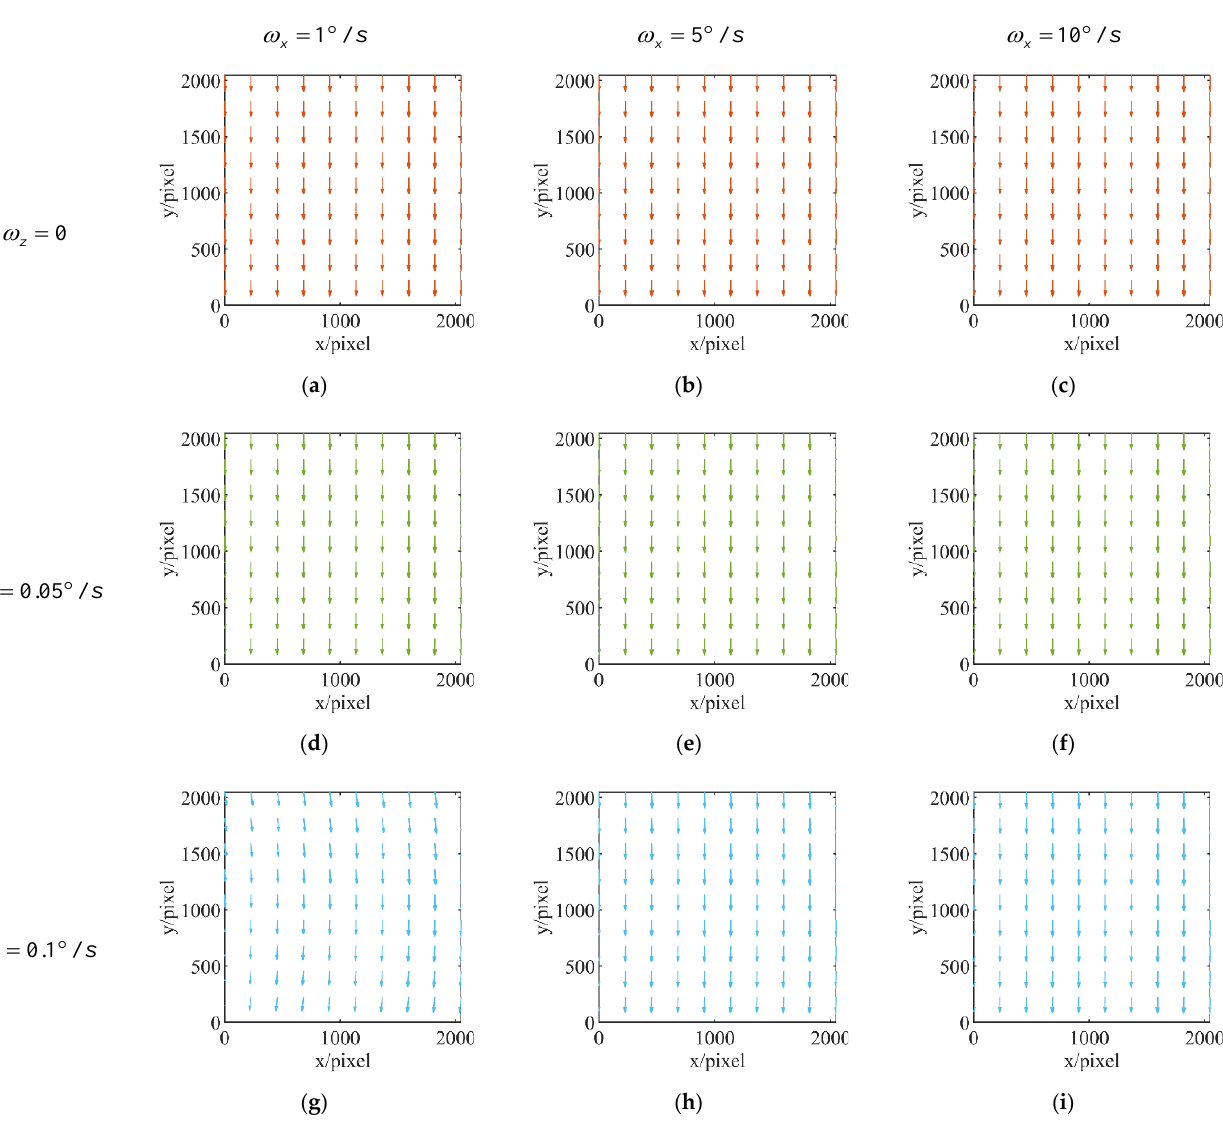
Figure 6. Velocity vector distribution diagram for different angular velocities. ( a – c ) The distribution of the velocity vector when ω z is equal to 0. ( d – f ) The distribution of the velocity vector when ω z is equal to 0.05 ◦ /s. ( g – i ) The distribution of the velocity vector when ω z is equal to 0.1 ◦ /s. As shown in Figure 6, the direction of star centroid velocity remains straight when ω z is equal to zero, and there is little effect on the velocity direction when ω z is not equal to zero. To analyze the specific effect of ω z on star centroid velocity, we analyze the magnitude and direction of the velocity when ω z is equal to 1 ◦ /s. As shown in Figure 7a, the direction of the velocity caused by ω z is symmetrical about the center of the field of view, and the velocity vector at the edge of the field of view has a larger magnitude than the velocity vector at the center of the field of view. The maximum velocity does not exceed 1.5 pixel/s. The star centroid is determined by the velocity and exposure time. The angular velocity error caused by the satellite control system is less than 0.01 ◦ /s [35]. Without considering the installation direction error, the angular velocity component in the z-direction is smaller than 0.01 ◦ /s during the imaging process, and the exposure time of the star tracker is no more than 200 ms. The influence of the velocity component in the z-direction is considered small enough to be ignored in this